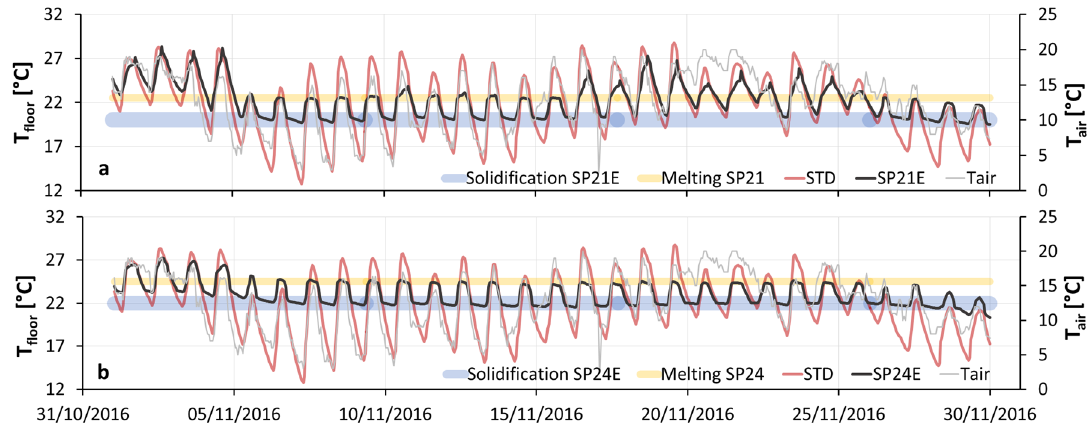
Figure 12. Floor temperatures compared to melting and solidification temperature range of PCM for the month of November in Rome: ( a ) SP21E; ( b ) SP24E.